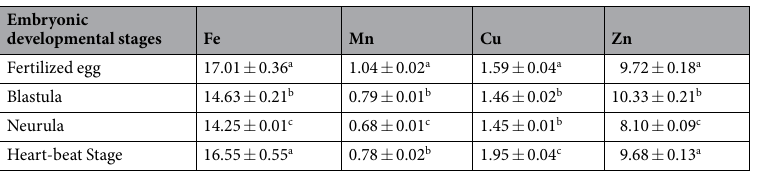
Table 3. The contents changes of microelements (mg/KG). Data are shown as mean ± SD (standard deviation) of each developmental stage in three separate individuals. Little letters indicate expression difference of microelements in different developmental stages.